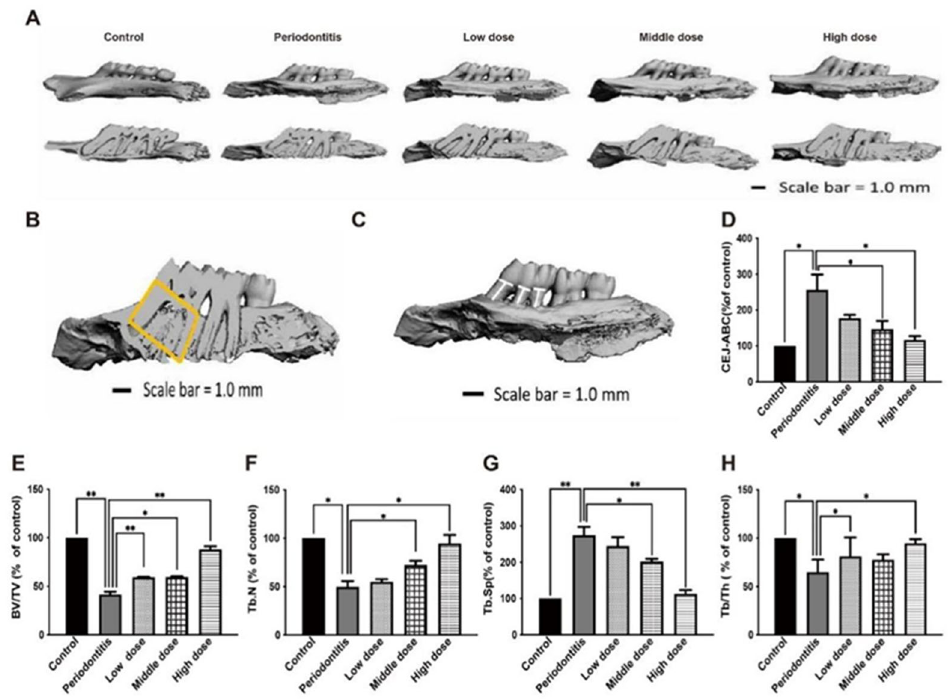
Figure 5. Effect of DhHP-6 on the bone microstructure around the left maxillary first molar in rats with periodontitis. ( A ) Three-dimensional reconstruction and misshapen maps of the left maxillary first molar of rats in each group. ( B ) Effect of DhHP-6 on the bone microstructure around the left maxillary first molar in rats with periodontitis. The yellow area is the region of interest (ROI) of alveolar bone selected in this study. After determining the ROI region, Micro-CT was used to analyze the bone structure parameters in this region. The parameters selected in this study included: BV/TV; Tb. Th; Tb. N; Tb. Sp. ( C , D ) Effect of DhHP-6 on the alveolar bone resorption of the left maxillary first molar in rats with periodontitis. The white line marks the CEJ-ABC distance. The bar chart shows the CEJ-ABC distance in each group. ( E – H ) Quantitative analysis of the area marked in yellow in panel B. * p < 0.05, ** p <